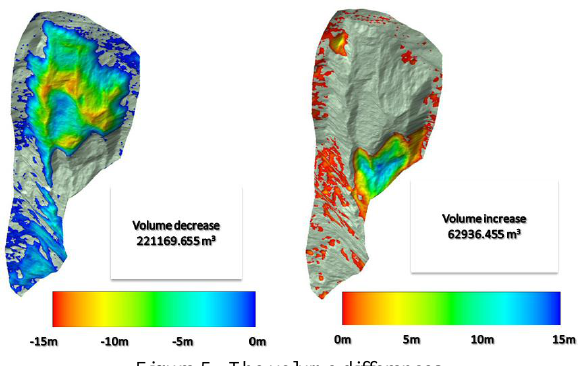
Figure 5. The volume